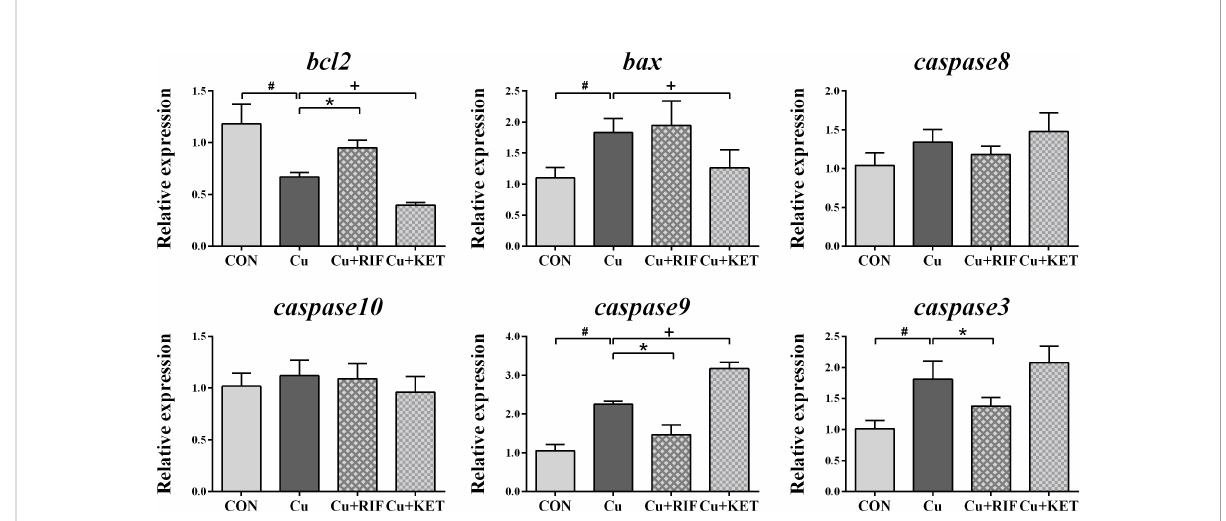
FIGURE 7 Hepatic mRNA levels of genes involved in apoptosis in largemouth bass subjected to RIF or KET under Cu exposure (n = 6). Signi fi cant differences between CON and Cu groups, Cu and Cu+RIF groups, as well as Cu and Cu+KET groups were indicated by “ # ” , “ * ” , and “ + ” ( P < 0.05).